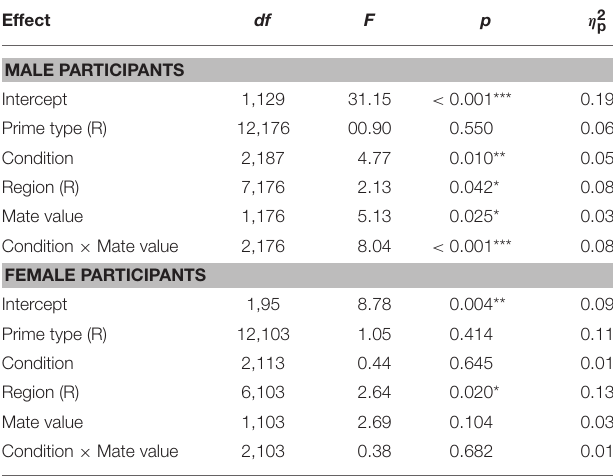
TABLE 1 | F -test results of univariate ANOVA testing the effect of gender equality condition and mate value on acceptance of intimate partner coercion, for male and female